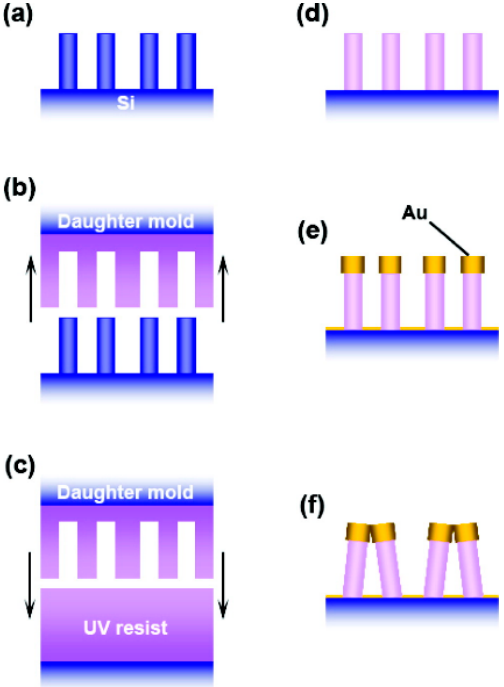
Figure 38. Fabrication of the nanopillar array with tips covered by a gold layer. ( a ) A silicon nanopillar array (master) is fabricated by EBL; ( b ) the master pattern is transferred to the polymer by ultraviolet (UV) curable nanoimprint lithography (NIL); ( c , d ) the final polymer nanopillar array is fabricated with a second round of NIL; ( e ) deposition of a gold layer; ( f ) exposition to the solvent and drying makes the nanopillars collapse on each other forming hot spots. Reproduced with permission form Ou et al. [358]. Copyright (2011), the American Chemical Society.